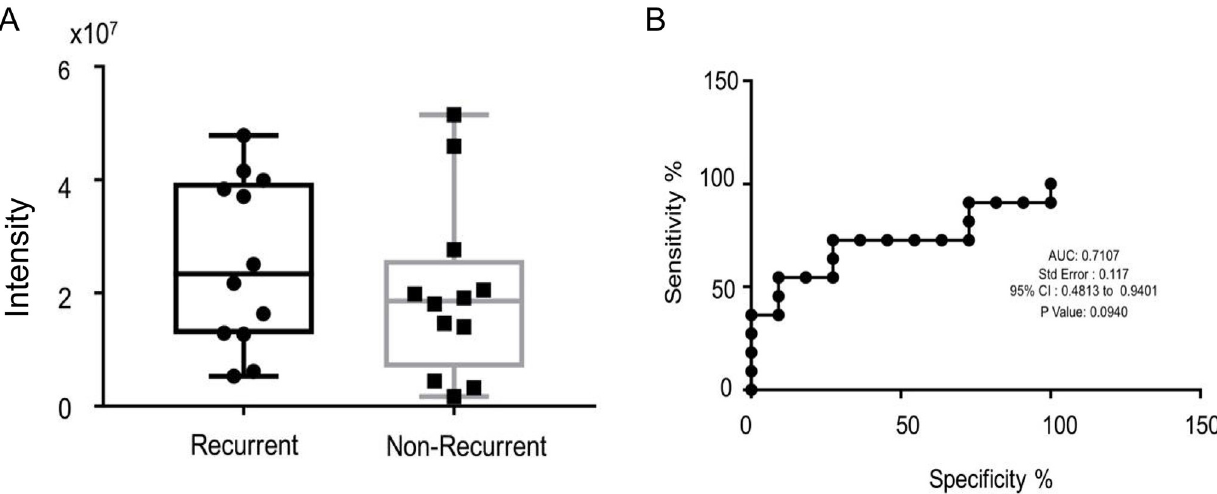
Fig 4. Recurrence and vitronection concentration level in serum. A . Overall concentration level of vitronectin in 21 recurrence samples (n = 21) and compared serum vitronectin concentration levels to 21 non-recurrence samples of same IHC sub-groups. B . Receiver Operation Characteristic (ROC) Curve and, the statistical evaluation of vitronectin concentration in serum samples between non-recurrence vs recurrence patients. We tested to see if vitronectin could be used as a recurrence biomarkers and, we found that the area under curve (AUC) is 0.7107 with a p-value 0.0940.